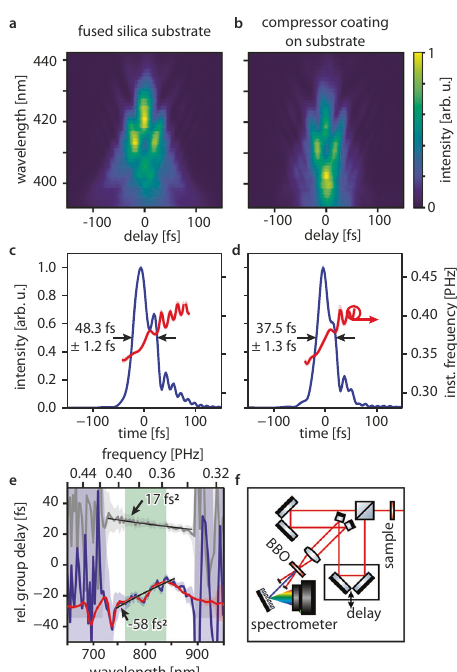
Fig. 4 Compression of an ultrashort laser pulse. a – b Experimental second- harmonic frequency-resolved optical-gating (SH-FROG) spectrograms recorded after the incoming laser pulses are transmitted a through the fused silica substrate only and b through the compressor-coated substrate (nanopillar diameter 162 nm). c Time-domain intensity (blue line) and instantaneous frequency (red line) pro fi les of the laser pulses transmitted through the fused silica substrate retrieved using an iterative ptychographic reconstruction algorithm (see methods). The arrows indicate the pulse full- width at-half maximum duration. Standard deviations (blue and red shaded areas) were determined using the bootstrap method (see methods). d Time-domain intensity (blue line) and instantaneous frequency (red line) pro fi les of the laser pulses transmitted through the compressor-coated substrate. The measured full-width at-half maximum durations show the pulse shortening by 11 fs. e group delay pro fi le retrieved from the SH-FROG measurements (SH-FROG measurement: blue line, white-light interferometer measurement of the same sample: red line) and least- squares fi t (black line) to the data in the full working range (light green area). The group delay pro fi le retrieved for the fused silica substrate (SH- FROG measurement: gray line) is displayed as a reference. f SH-FROG setup. The incoming laser pulses (red lines) are modi fi ed by the sample, split and delayed by the arms of an interferometer, and subsequently focused and overlapped noncollinearly in a beta-Barium-Borate (BBO) crystal. Second-harmonic radiation (blue line) generated by combining one photon from each arm is detected in a grating spectrometer for different delay times and reveals the temporal structure of the laser pulses.